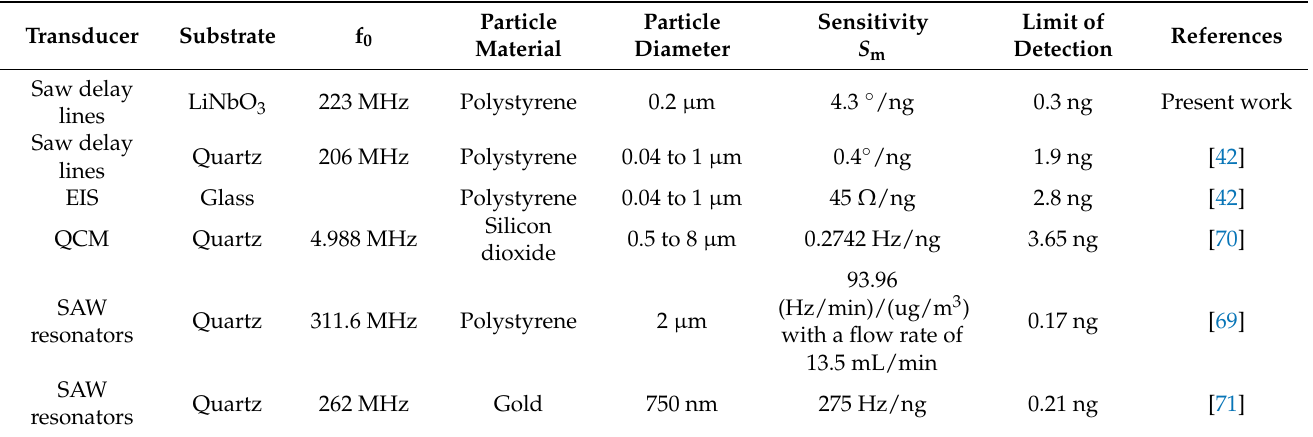
Table 2. Comparison of the literature work on the detection of nanoparticles by means of acoustic transduction methods with our